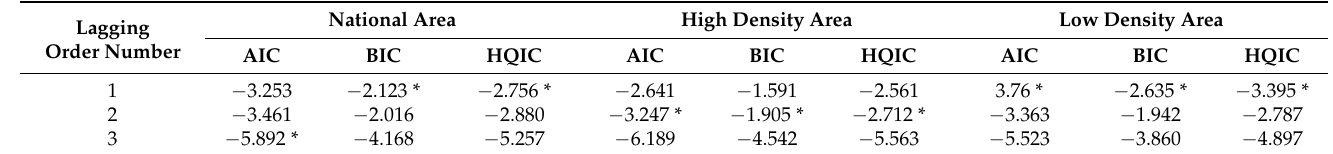
Table 3. Delay test